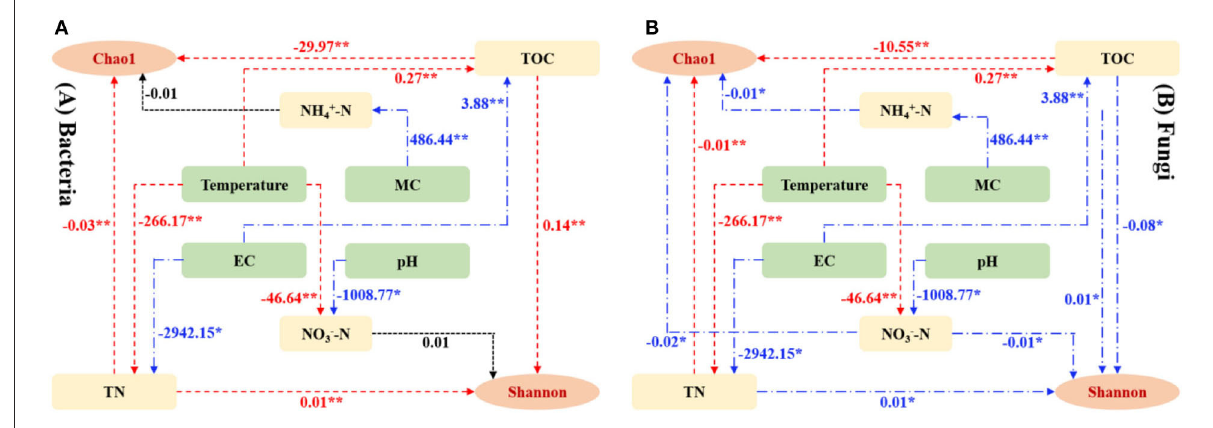
FIGURE8 Structure equation models (SEMs), representing hypothesized causal correlations between bacterial (A) and fungal (B) communities as well as physico-chemical